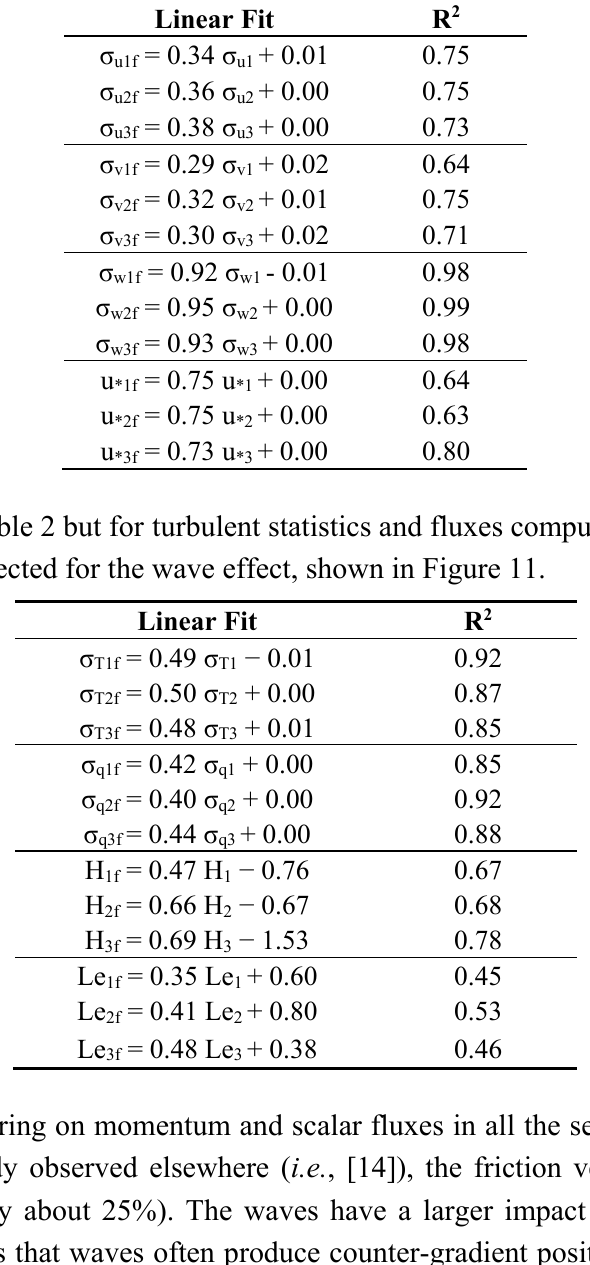
Table 2. Linear regression analysis of turbulent statistics and fluxes computed by using the original fluctuations and corrected for the wave effect shown in Figure 10. The subscribed numbers refer to different levels of measurements (1 → 10 m; 2 → 4.5 m; 3 → 2 m). R 2 is the coefficient of determination associated with the regression analysis.